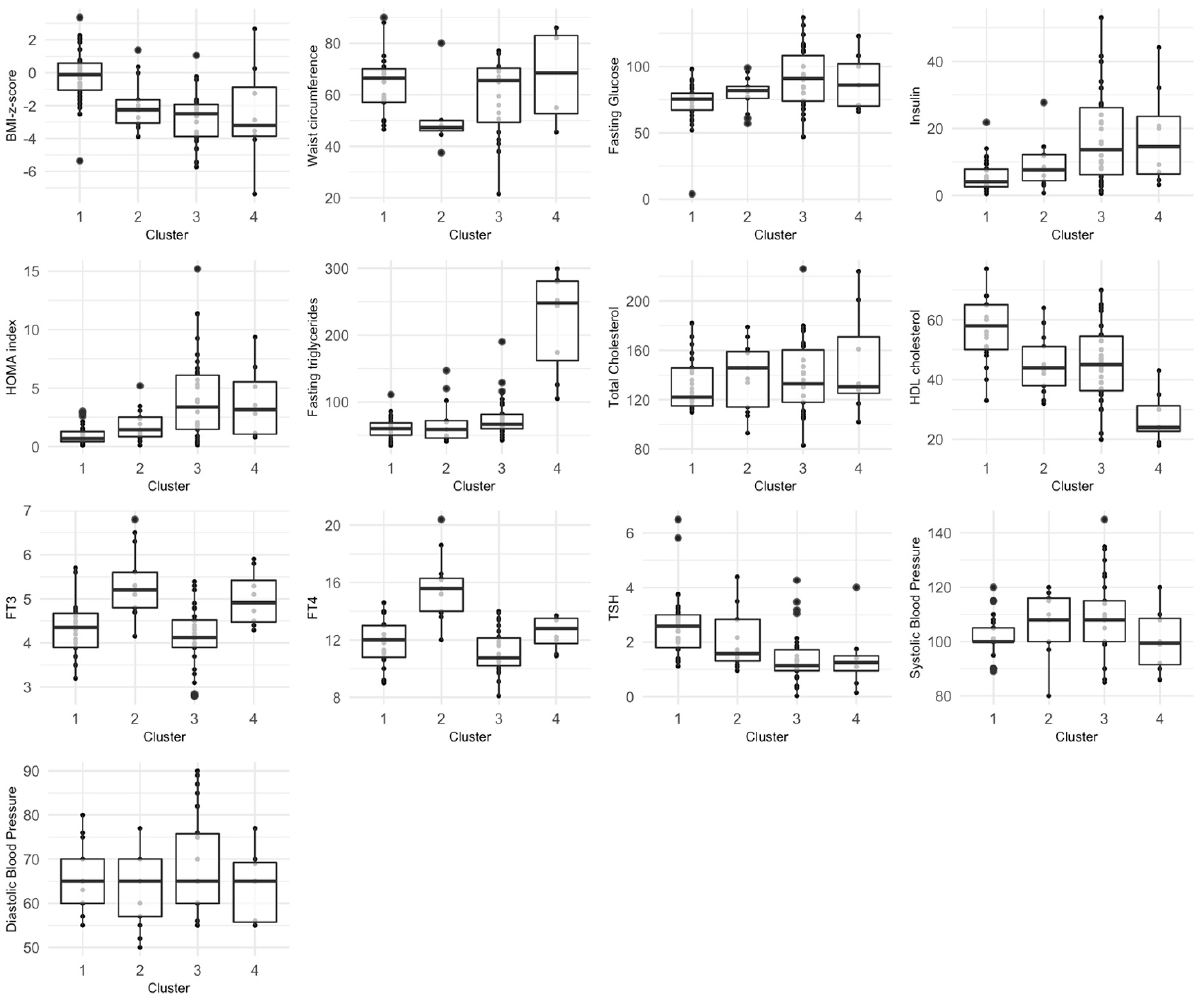
Figure A2. Correlation coefficients ( A ) and p -values ( B ) for the associations in PCA analysis.